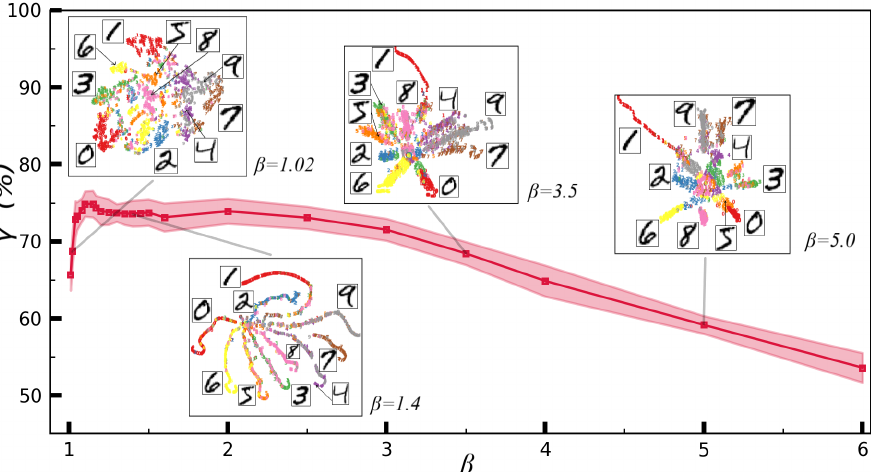
Figure 1. The β dependence of the testing accuracy γ of the testing samples for the ten classes in the MNIST dataset, where ε t is evaluated by randomly taking N=10 training samples from each classes. Note the RLF becomes the standard fidelity for β = 10. We take the average of ε t by implementing the simulations for 20 times, and the variances are indicated by the shadowed area. By t-SNE, the insets show the visualized distributions of 2000 effective vectors { ˜ y } ( Equation (5)) that are randomly taken from the testing